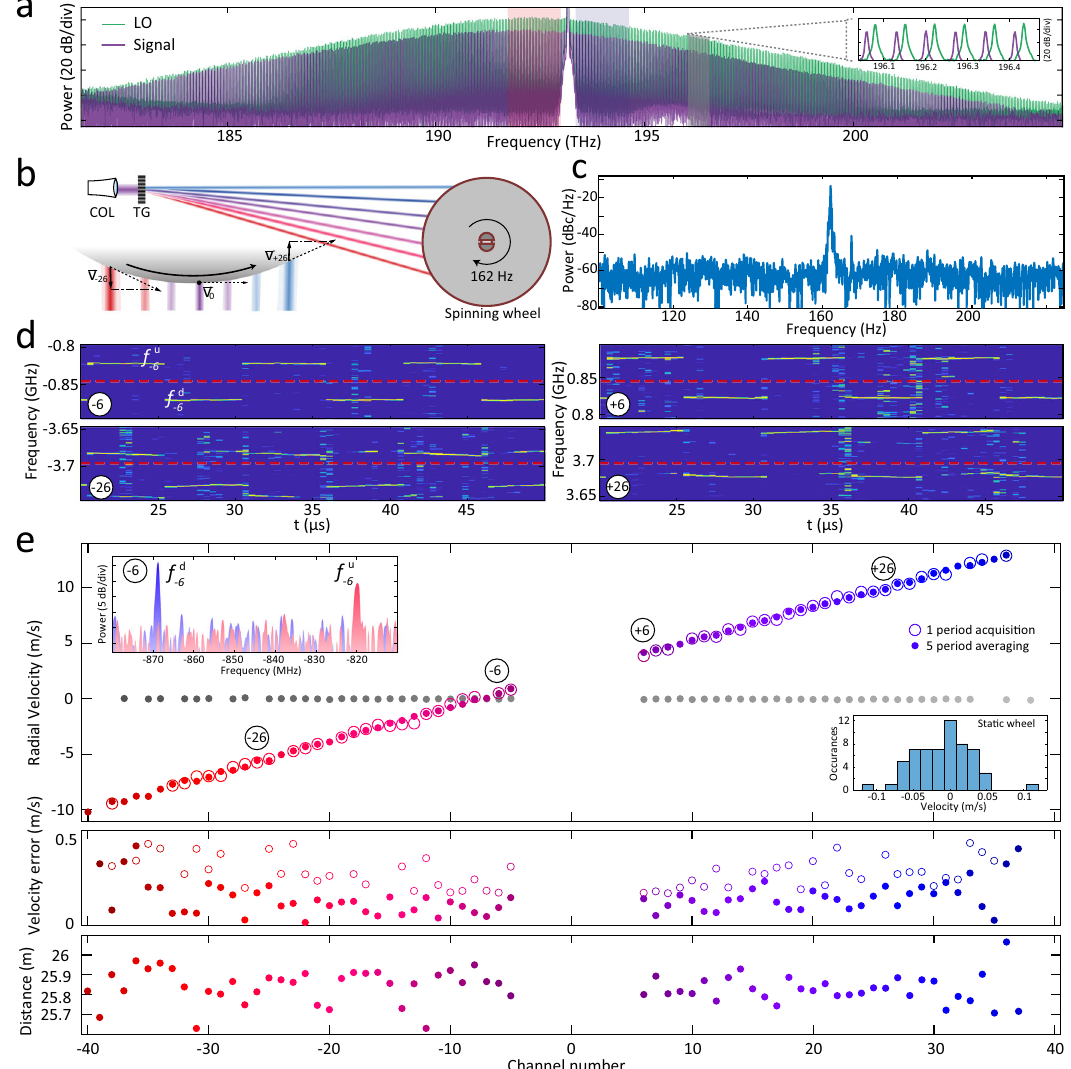
Fig. 4 Dense dual-comb parallel velocimetry measurement at 6.4 megapixel/second rates. a Optical spectra of the 35 GHz dual FMCW combs. b Schematic illustration of the fl ywheel section irradiated by the signal comb lines. (Left) COL Collimator, TG transmission grating. (Right) The projections of the velocity v μ of the wheel onto the comb lines. c Periodogram of the spinning fl ywheel sound recorded on a cellphone microphone depicting a peak corresponding to the rotation frequency. d Time-frequency map featuring an offset of the mean beat frequency from the μ Δ f rep due to the Doppler shift. ENBW 2.45 MHz. e (Top) Multichannel velocity measurement for the fl ywheel rotating at 162 Hz for a single 10 μ s scan (open circles) and fi ve frame stacking ( fi lled circles). Grey data points show velocimetry results for the static wheel. The left inset shows the Fourier transform of the signal current in the RF band corresponding to μ = − 6 channel recorded over one period. The right inset shows a static wheel velocity histogram. (Middle) Error of velocimetry for single scan and fi ve frame stack. (Bottom) Ranging results for fi ve frame